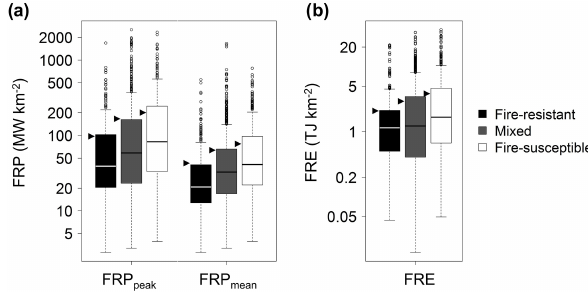
Figure 2. Fire radiative power (a) and fire radiative energy (b) dis- tributional statistics grouped by dominant forest composition (fire- resistant to fire-susceptible). Black arrows indicate mean